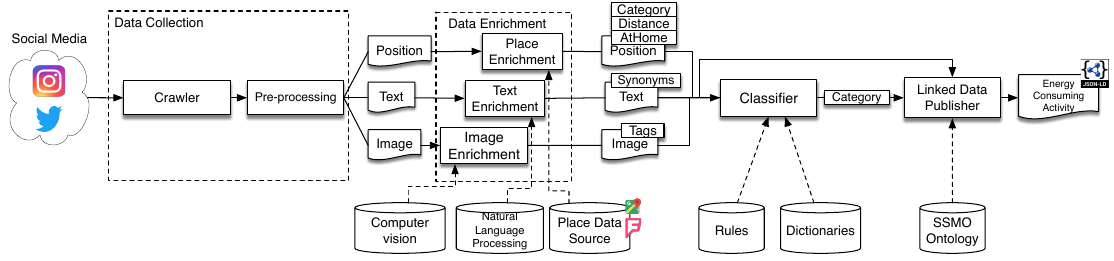
Figure 4. Overview of the data processing